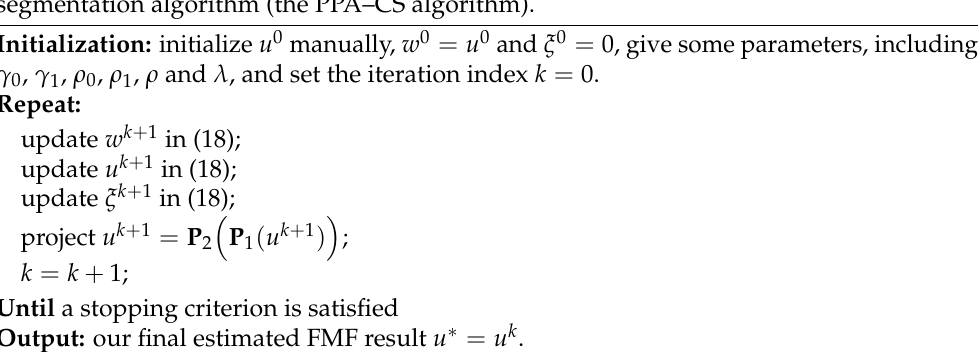
Figure 1. The figure of methodology of the proposed PPA-CS method. Algorithm 1 Our proposed plug-and-play neural network-based convex shape image segmentation algorithm (the PPA–CS